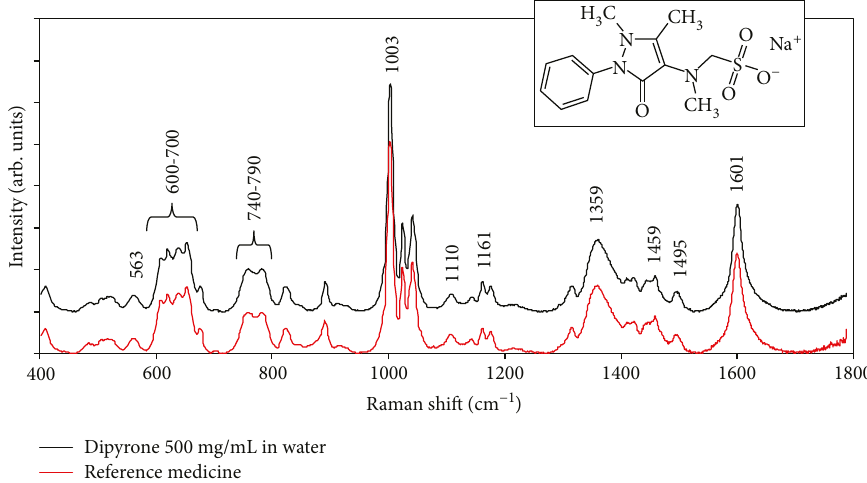
Figure 2: Plot of the spectrum of dipyrone diluted in water in the concentration of 500mg/mL (100% dilution) and the fi rst three principal component loading vectors (LVs), indicating that LV1 is related to the active ingredient dipyrone. LV2 and LV3 do not carry relevant spectral